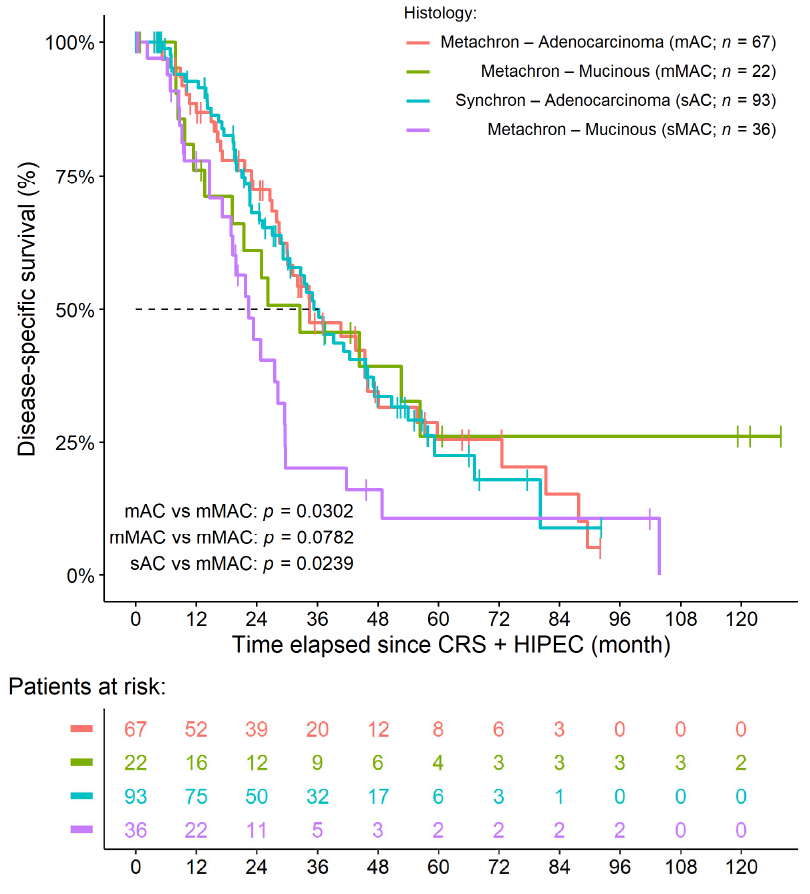
Figure 3. Survival curves of colorectal cancer patients with synchronous and metachronous peritoneal metastasis. The histological diagnosis of mucinous adenocarcinoma in the synchronous cohort was associated with inferior survival compared to all other study cohorts. No statistical difference could be found for the comparisons between the remaining groups. Table 5. Comparison of the survival of the four study groups. The orange and blue sections show the disease ‐ specific and overall survival between ‐ group p ‐ values, respectively.